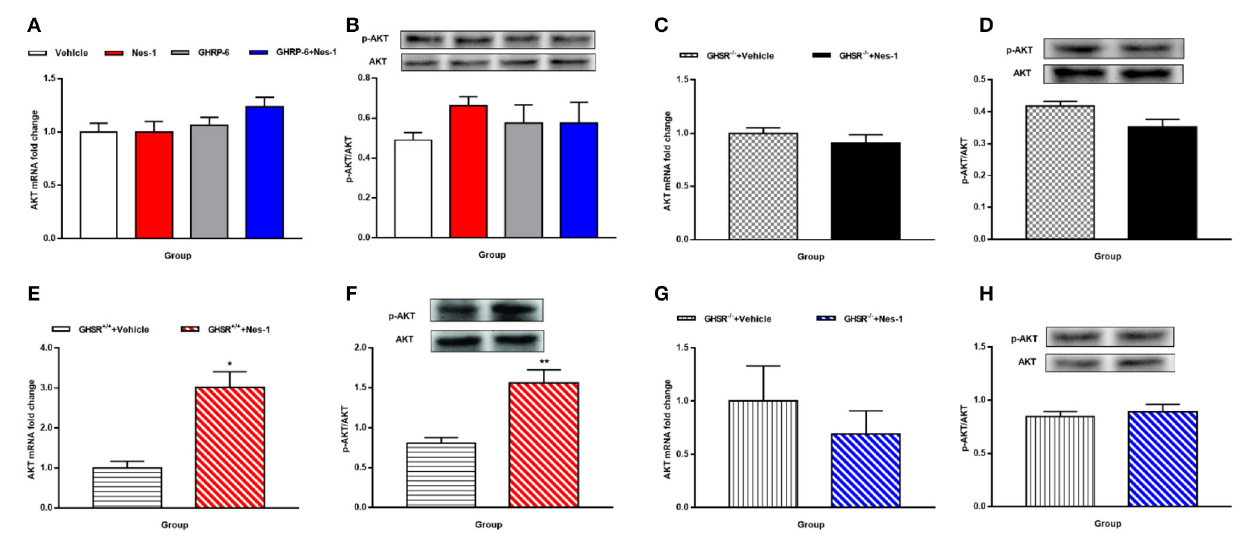
FIGURE 7 | GHSR mediated the effect of nesfatin-1 on AKT phosphorylation in liver of HFD-fed mice. GHSR + / + mice underwent chronic tail vein administration of vehicle, nesfatin-1 (Nes-1), [D-Lys3]-GHRP-6 (GHRP-6) and [D-Lys3]-GHRP-6 + nesfatin-1 (GHRP-6 + Nes-1) for 12 days. GHSR − / − mice fed underwent chronic tail vein administration of vehicle and nesfatin-1 for 12 days. Insulin (2 IU/kg) was intraperitoneally injected into mice 10min before mice were sacrificed. (A,C,E,G) mRNA expression levels of AKT detected by RT-PCR in liver of (A) GHSR + / + , (C) GHSR − / − mice fed NCD and (E) GHSR + / + , (G) GHSR − / − mice fed HFD. (B,D,F,H) P-AKT/AKT level in liver of (B) GHSR + / + , (D) GHSR − / − mice fed NCD and (F) GHSR + / + , (H) GHSR − / − mice fed HFD. (A,B) n = 5/group; (C,D) n = 3/group; (E–H) n = 5/group. Data are expressed as mean ± SEM. * P < 0.05; ** P < 0.01 for the effect of nesfatin-1 vs. vehicle. (A,B) One-way ANOVA was applied to analyze the statistical difference for multiple groups. (C–H) Student’s t -test was applied to analyze the statistical difference for two groups.